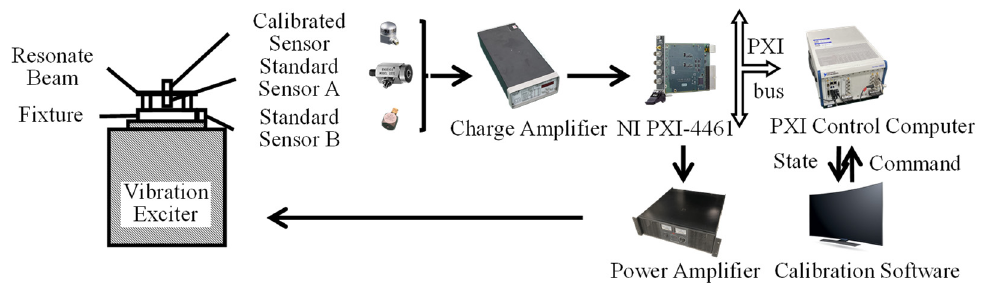
Figure 2. High-acceleration calibration device.